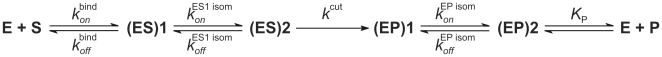
The kinetic scheme describing the interactions of APE1K98A with specific F- and AP-substrates during BER.